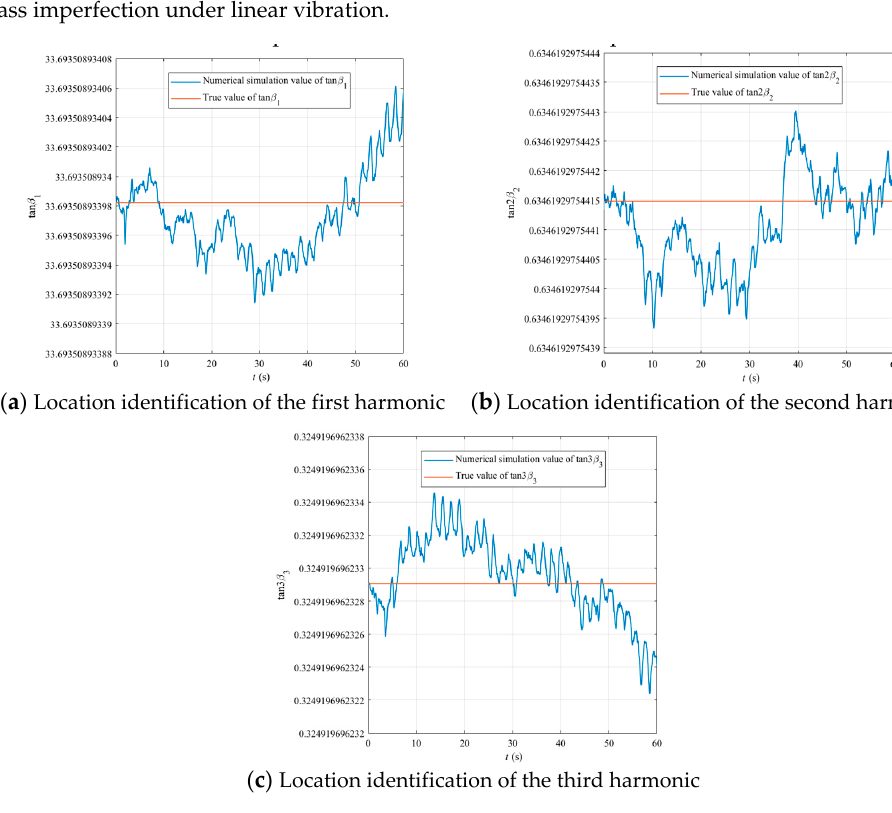
Figure 7. Location identification of the first–third harmonics of mass imperfection of a hemispherical resonator under linear